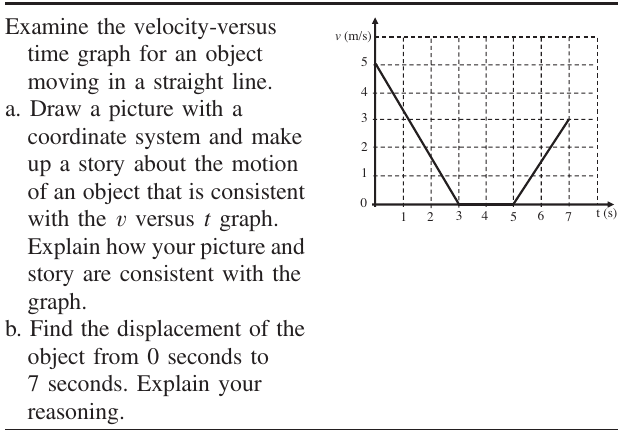
TABLE III. An example of a problem that engages the ability to represent information in multiple ways. Examine the velocity-versus time graph for an object moving in a straight line.